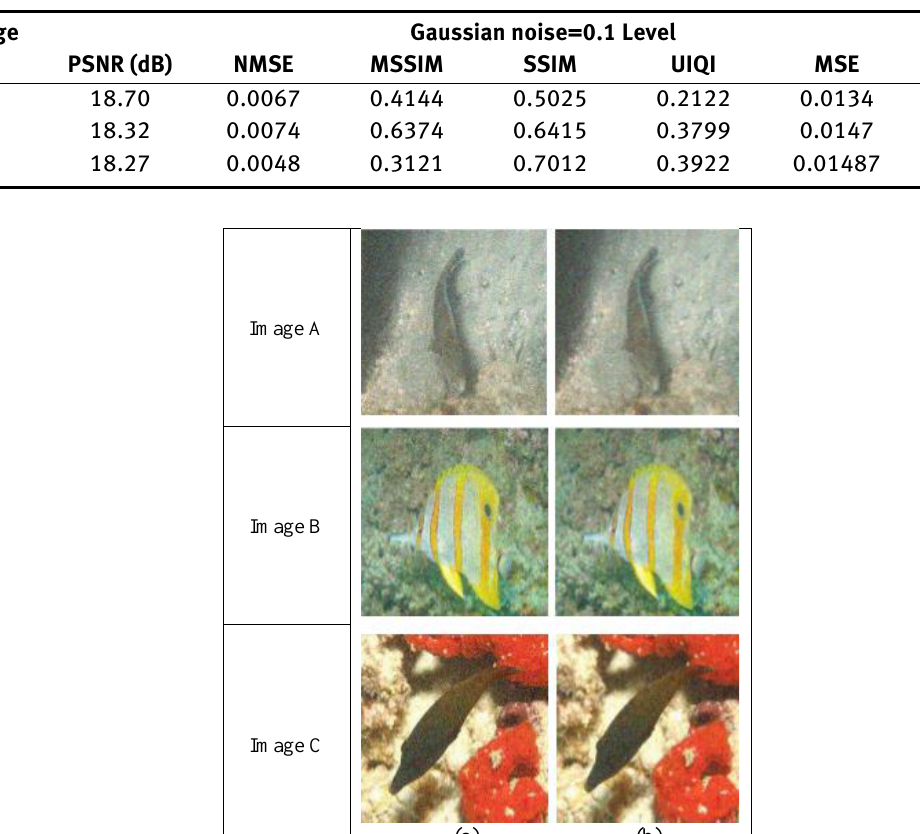
Table 4: Performance of modified fuzzy set filter by adding 0.1 level of Gaussian noise